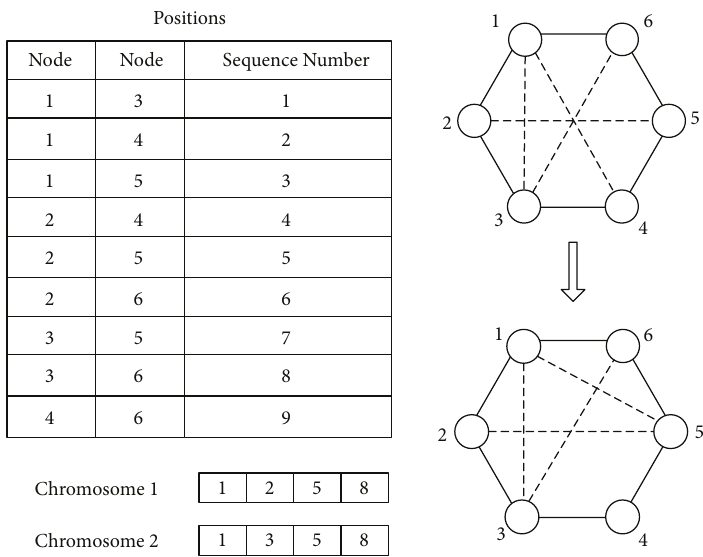
Figure 2: Illustration of genetic representation.Upper left lists the unconnectedpairs of nodes and their sequence numbers. Lower left shows the corresponding chromosomes. Right shows the network topology corresponding to chromosomes. The solid lines represent the original edges of the network, the dashed lines represent added edges, and the numbers next to nodes denote the node number.